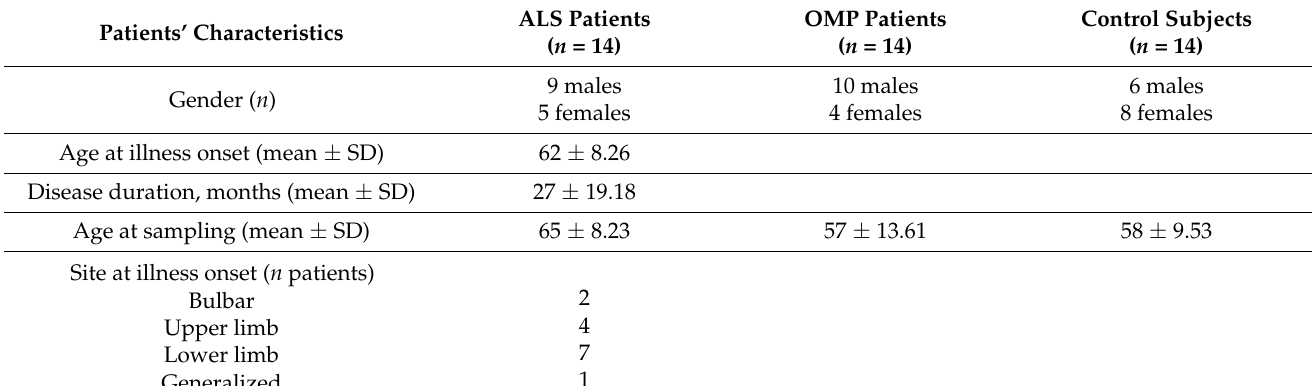
Table 1. General and Clinical Characteristics of the Participants in the Blood Study Cohort. Patients’ Characteristics